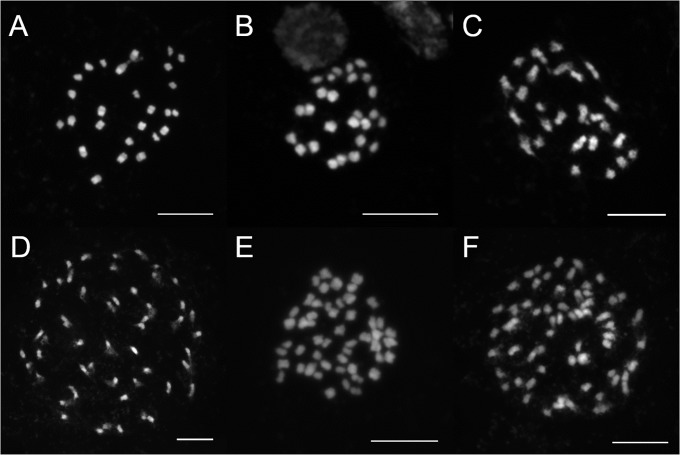
Microphotographs of somatic metaphases of Urtica dioica.(A) U. d. subsp. pubescens (population UP0009, Italy) − 2n = 2x = 26; (B) U. d. subsp. sondenii (population UP0584, Finland) − 2n = 2x = 26; (C) U. d. subsp. subinermis (population UP0059, Czech Republic) − 2n = 2x = 26; (D) U. d. subsp. dioica (population UP0033, France) − 2n = 4x = 52; (E) U. d. subsp. dioica (population UP0718, Iran) − 2n = 4x = 52; (F) Pentaploid cytotype of U. dioica (population UP0770, Czech Republic) − 2n = 5x = 65 (morphologically identical with U. d. subsp. dioica).